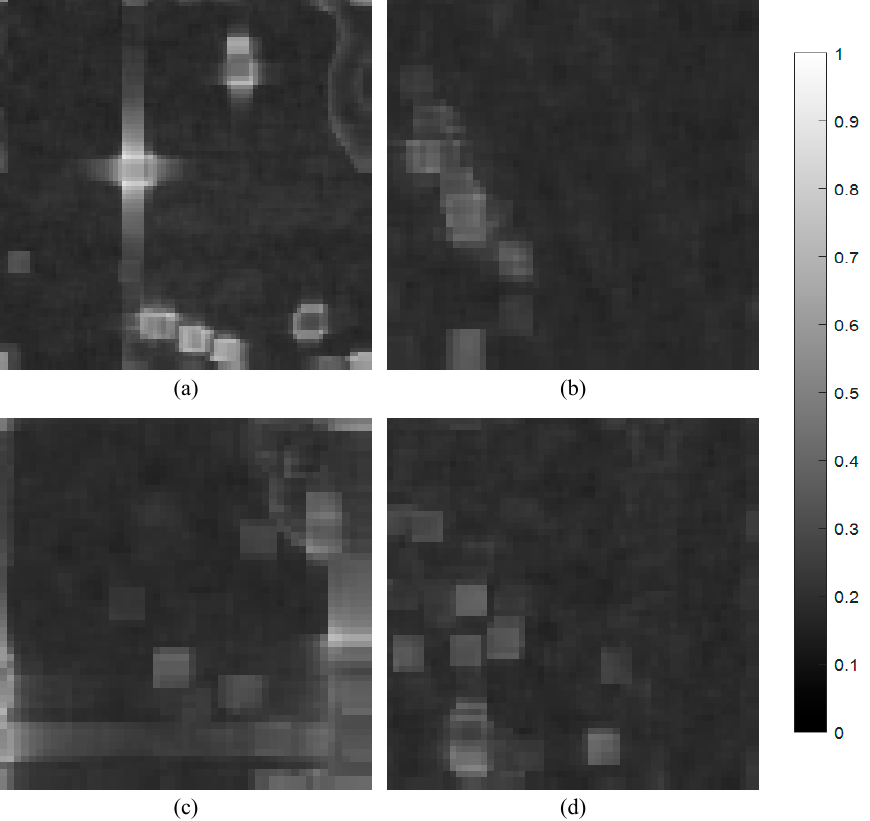
Figure 8. Stack-averaged coherence changes in magnitude for ( a ) Lvshungang, ( b ) Dingxin, ( c ) Sasebo, and ( d ) Jinmen. The dark areas indicate low coherence and cover the majority of the observation areas, owing to the multi-angle scattering sensibility. It is difficult to separate them from the motion signals, which could also appear as low coherence in normal resolution cases.